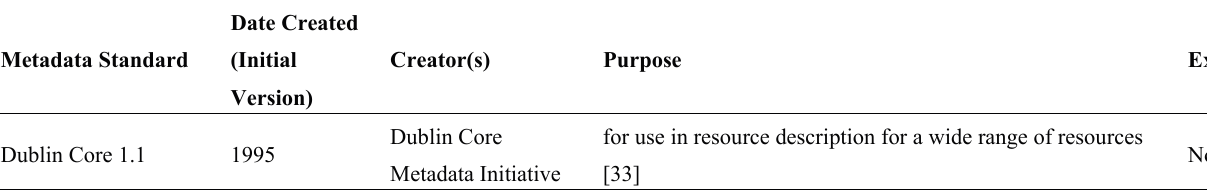
Table 2. Metadata standards selected for